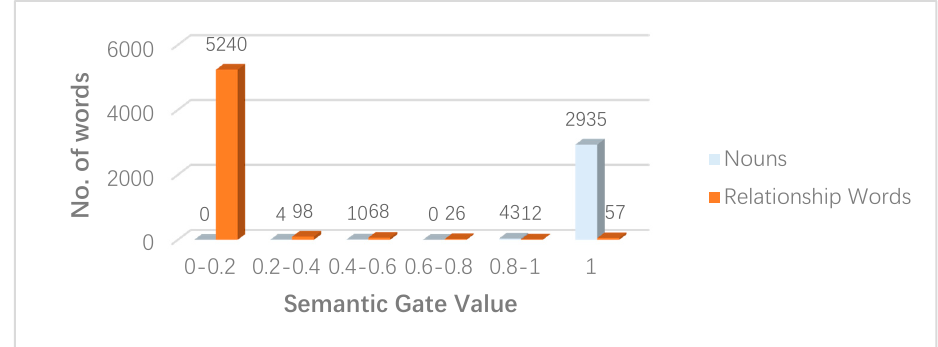
Figure 18. Effect of semantic gate with customized activation.